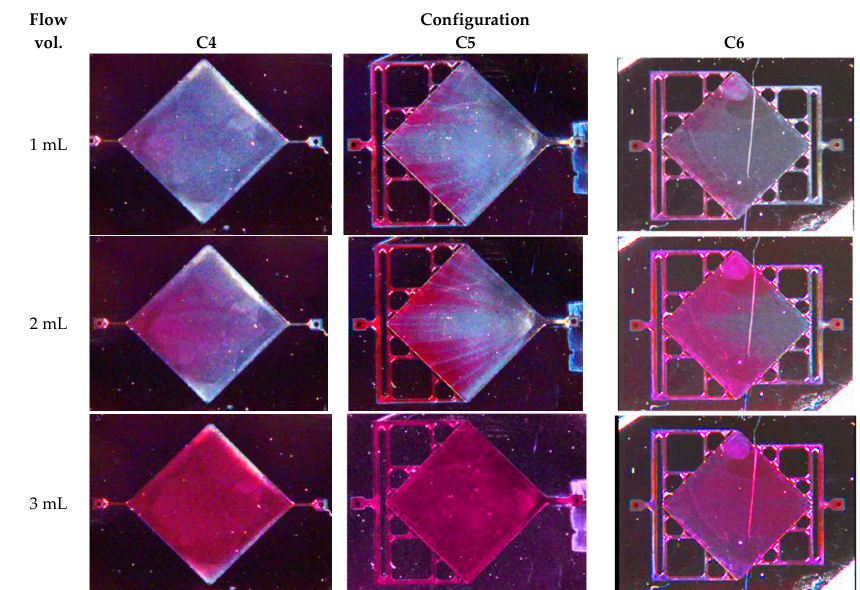
Figure 13. Flush sequence (shown as a function of liquid volume to facilitate comparison) in configurations (C4), (C5), and (C6) (red tinted water is entering from the left) (see movie for C5 configuration in online additional materials).